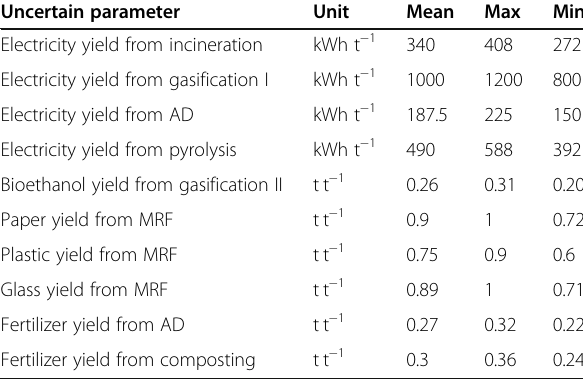
Table 5 Uncertain parameters and domain definition with uniform probability distribution Uncertain parameter